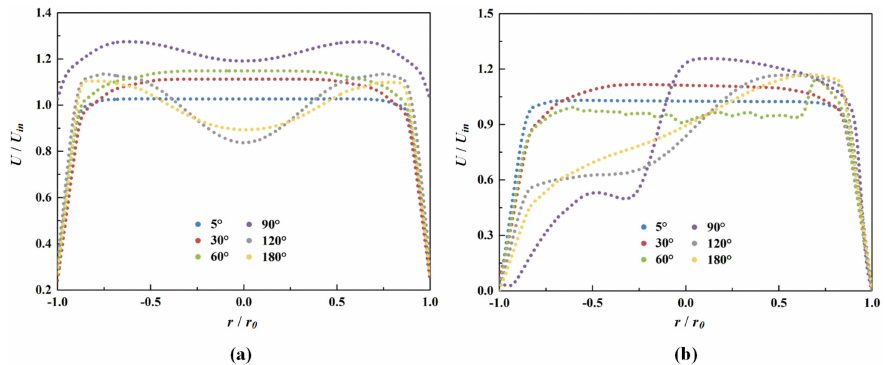
Figure 9. Velocity distribution of ( a ) horizontal and ( b ) vertical centerline at 0.67 D cross − section of downstream bend pipe with different bending